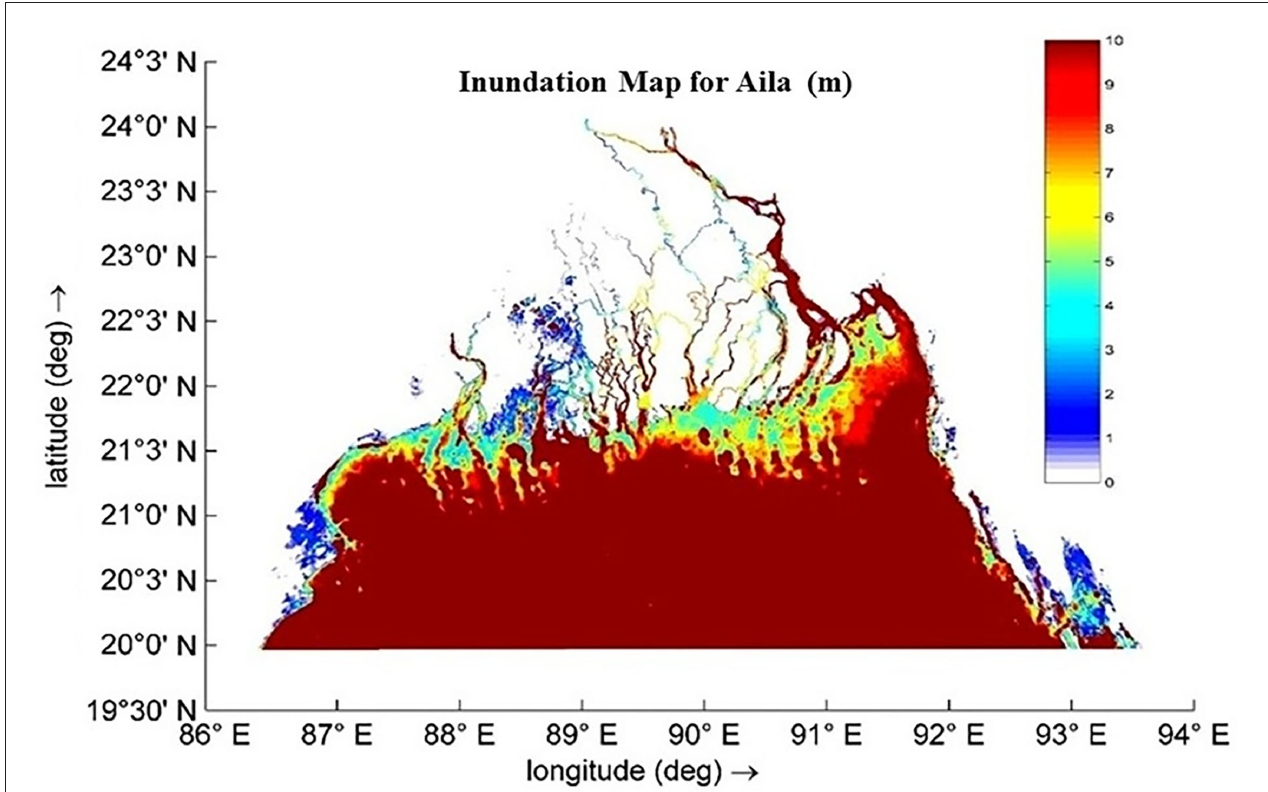
FIGURE 12 | Simulated storm surge inundation due to cyclone Aila during landfall